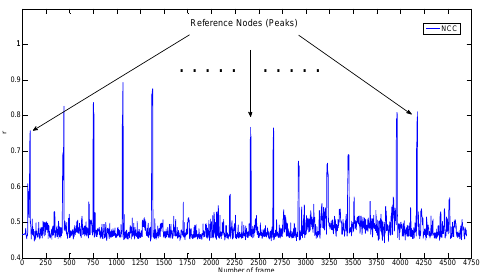
Figure 7. The image-matching results of RNs based on the NCC approach as an MT (BN) move along the test